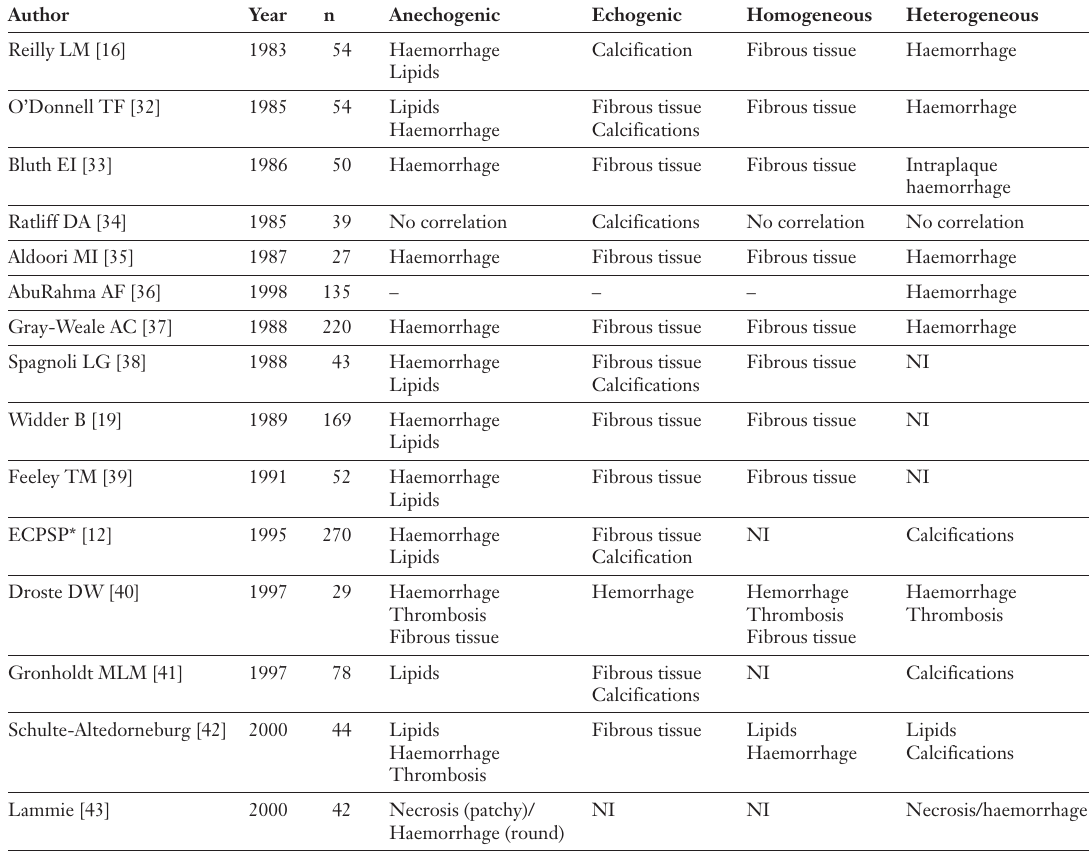
Table 1 Correlation between plaque morphology on ultrasound and histological composi- tion (based on visual